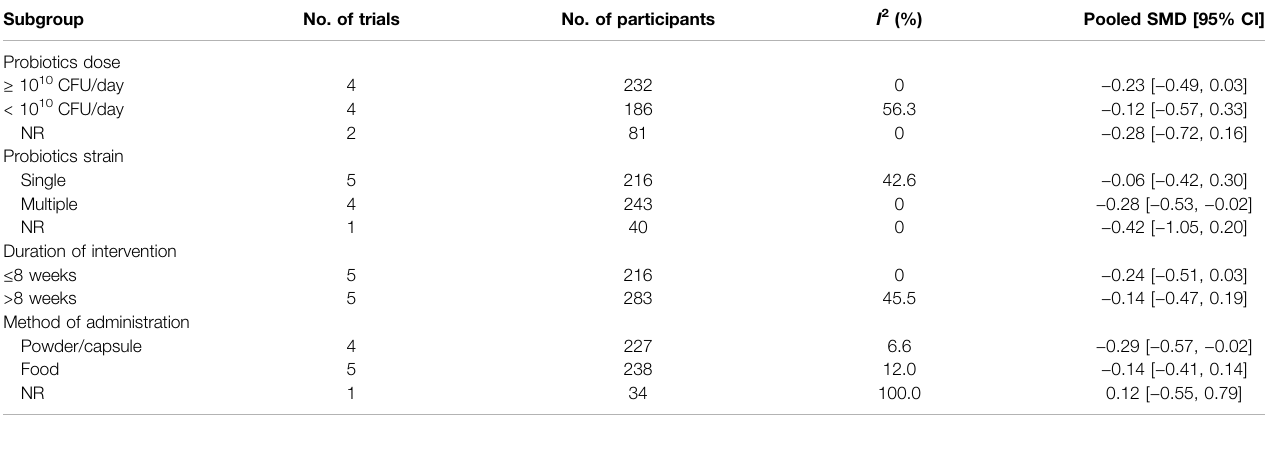
TABLE 6 | Subgroup analysis for the effects of probiotics on HbAlc.